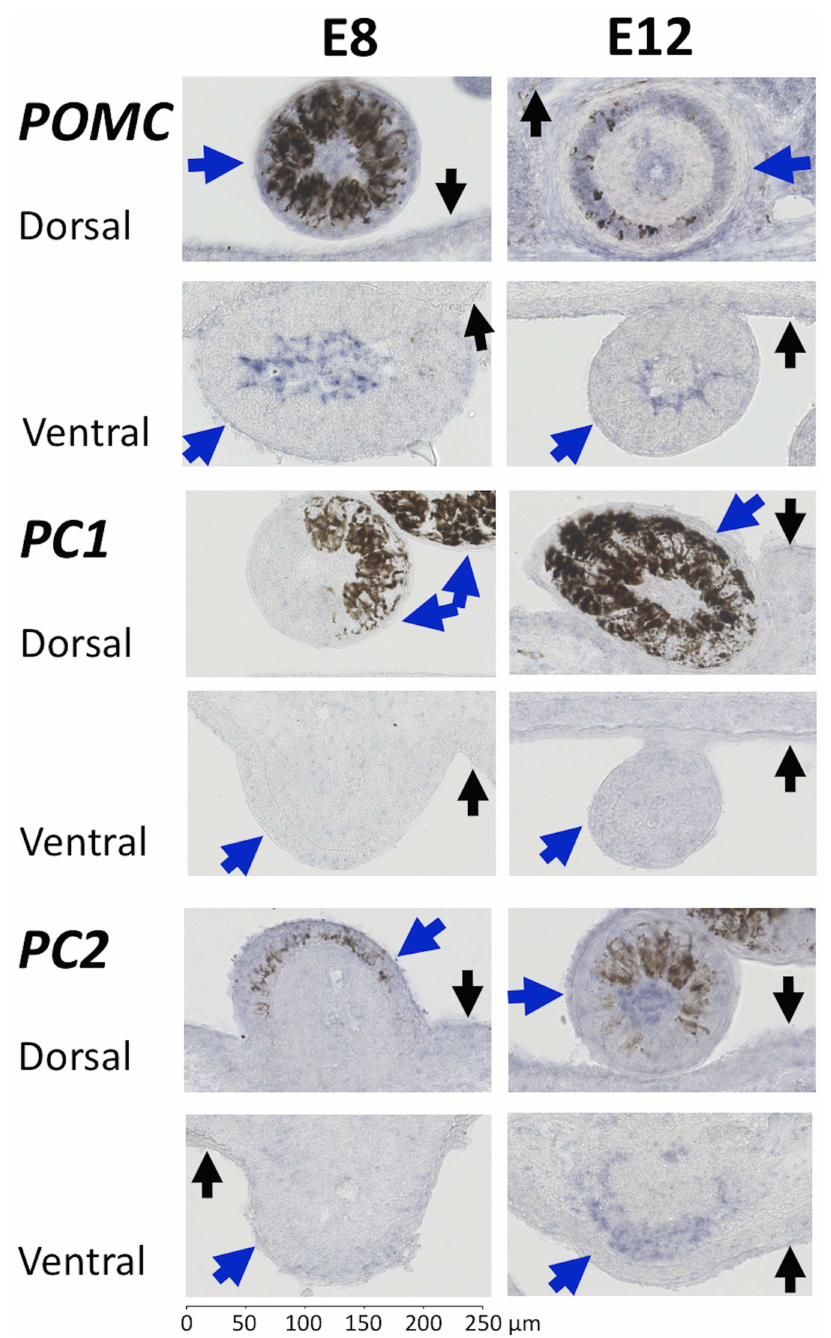
Fig 6. Patterns of expression of POMC , PC1 and PC2 in feather follicles at E8 and E12. The epidermisis labelledwith a small black arrow and feather follicleswith a large blue arrow. POMC is expressedin the dermalpulp of ventral and dorsal feather follicles in E8 and E12 embryos. Weak expressionof PC1 was observedin developingfeather follicles but did not developfurther at E12. There is weak transcription of PC2 at E8 on both ventral and dorsal surfaces, but when feather development is more progressed(e.g. E12), PC2 is strongly expressedin feather follicles on both the ventral and dorsal surface.